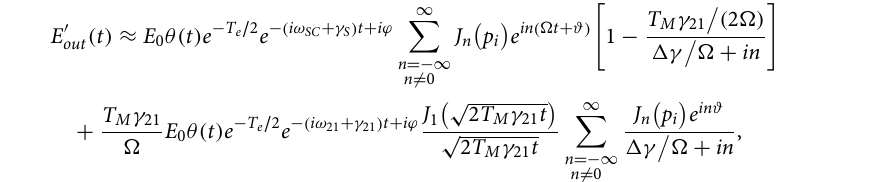
can be integrated and reduced to the form